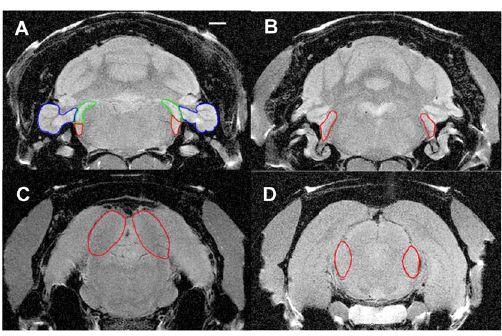
Figure 1. Typical AOI boundaries used in MEMRI quantifica- tion. A. Paraflocculus (PFL) blue, dorsal cochlear nucleus (DCN) green, posterior ventral cochlear nucleus, red. The 2 mm scale bar applies to all panels. B. Anterior cochlear nucleus (AVCN). C. Inferior colliculus (IC).